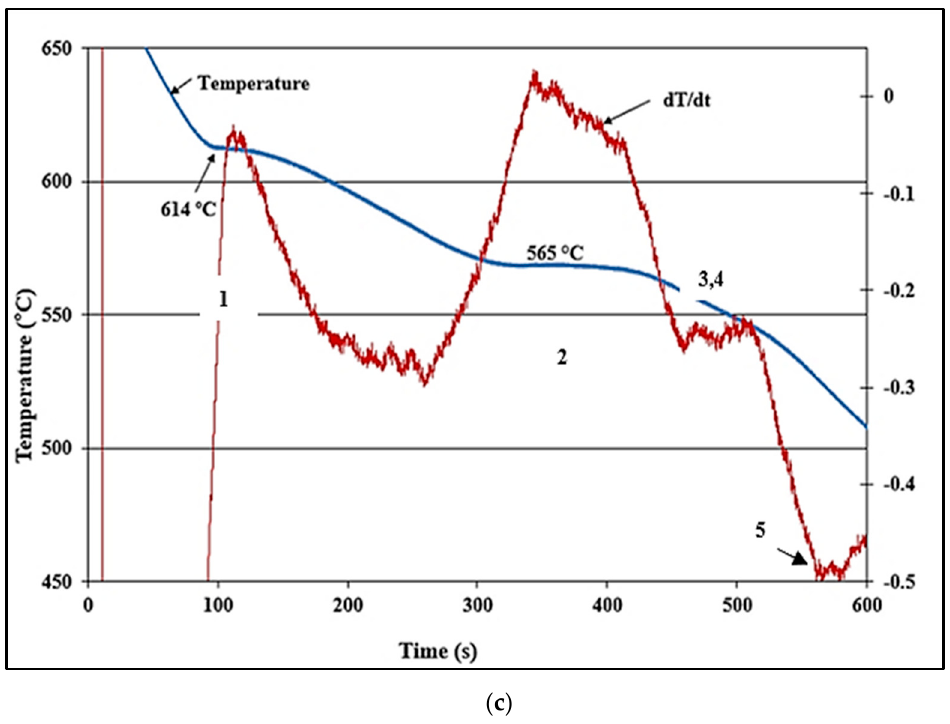
Figure 6. Solidification curves of the A356.2 alloy: ( a ) without a grain refiner, ( b ) effect of solidification rate, and ( c ) fully grain refined alloy.